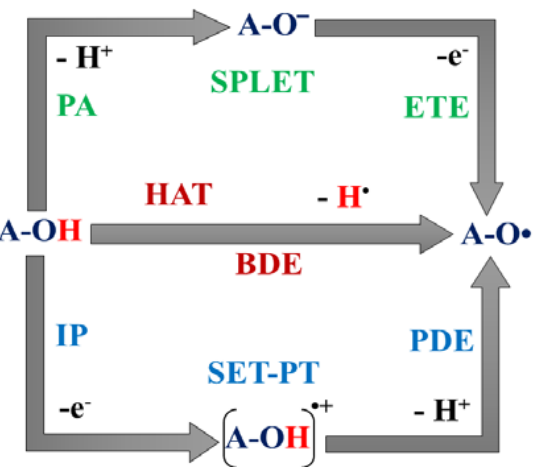
Figure 2. Schematic representation of the studied radical scavenging mechanisms through a hy- droxyl group: hydrogen atom transfer (HAT), single electron transfer-proton transfer (SET-PT), and sequential proton loss electron transfer (SPLET). A—antioxidant, OH—hydroxyl group. BDE: bond dissociation enthalpy, IP: ionization potential, PDE: proton dissociation enthalpy, PA: proton affinity, and ETE: electron transfer enthalpy.